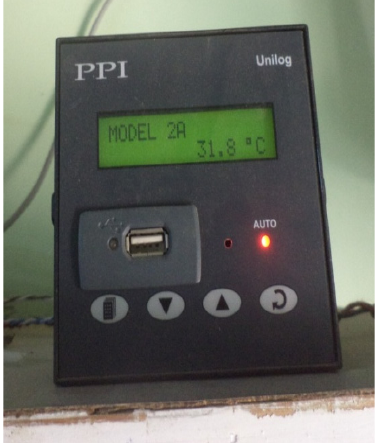
Figure 11. Data Logger.